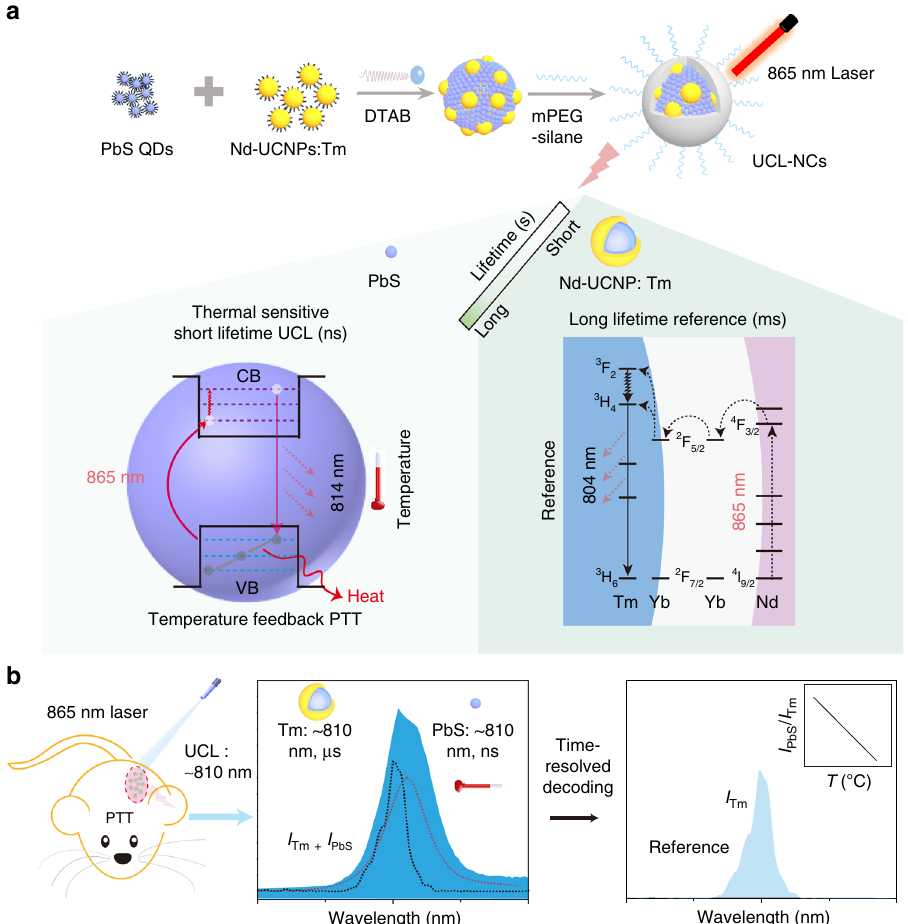
Fig. 1 Schematic of UCL-NCs for the same wavelength ratiometric thermometry. a Schematic of the formation and illustration of the proposed energy- transfer mechanisms of the UCL-NCs. The UCL-NCs exhibit both long lifetime and short lifetime UCL emission. The temperature-sensitive short lifetime UCL emission is obtained from PbS via a single photon assisted process. The reference long lifetime UCL emission is achieved via fabricating a core – shell- shell Nd-sensitized Tm-UCNP. The heat is produced through a non-radiative process in PbS. b Schematic illustration of the same wavelength ratiometric temperature monitoring in vivo. The temperature-sensitive short lifetime UCL emission and the reference long lifetime UCL emission are decoded using a time-resolved technique. The temperature is calculated from the ratio of UCL PbS to UCL Tm-UCNP